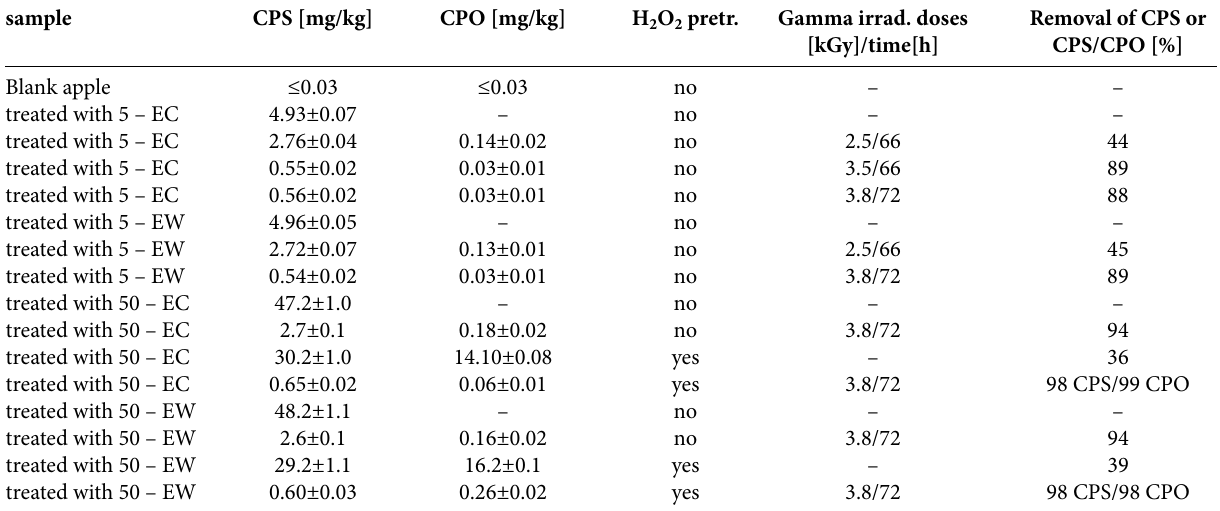
Table 2 . Removal of CPS and CPO by gamma ray irradiation and, if used, by H 2 O 2 pre-treatment. Values were determined by UPLC-PDA . sample CPS [mg/kg] CPO [mg/kg] H 2 O 2